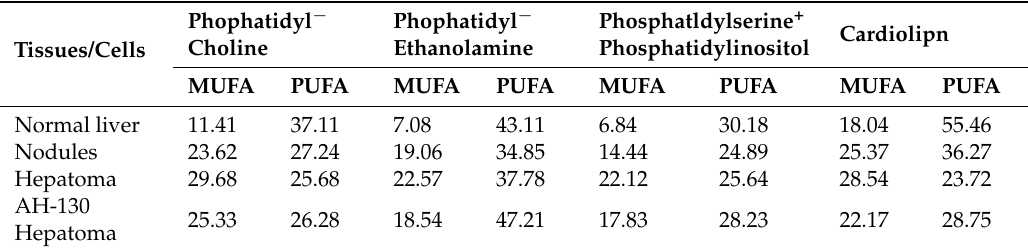
Table 2. Monounsaturated and polyunsaturated fatty acid content in phospholipid classed of mitochondria isolated from rat liver